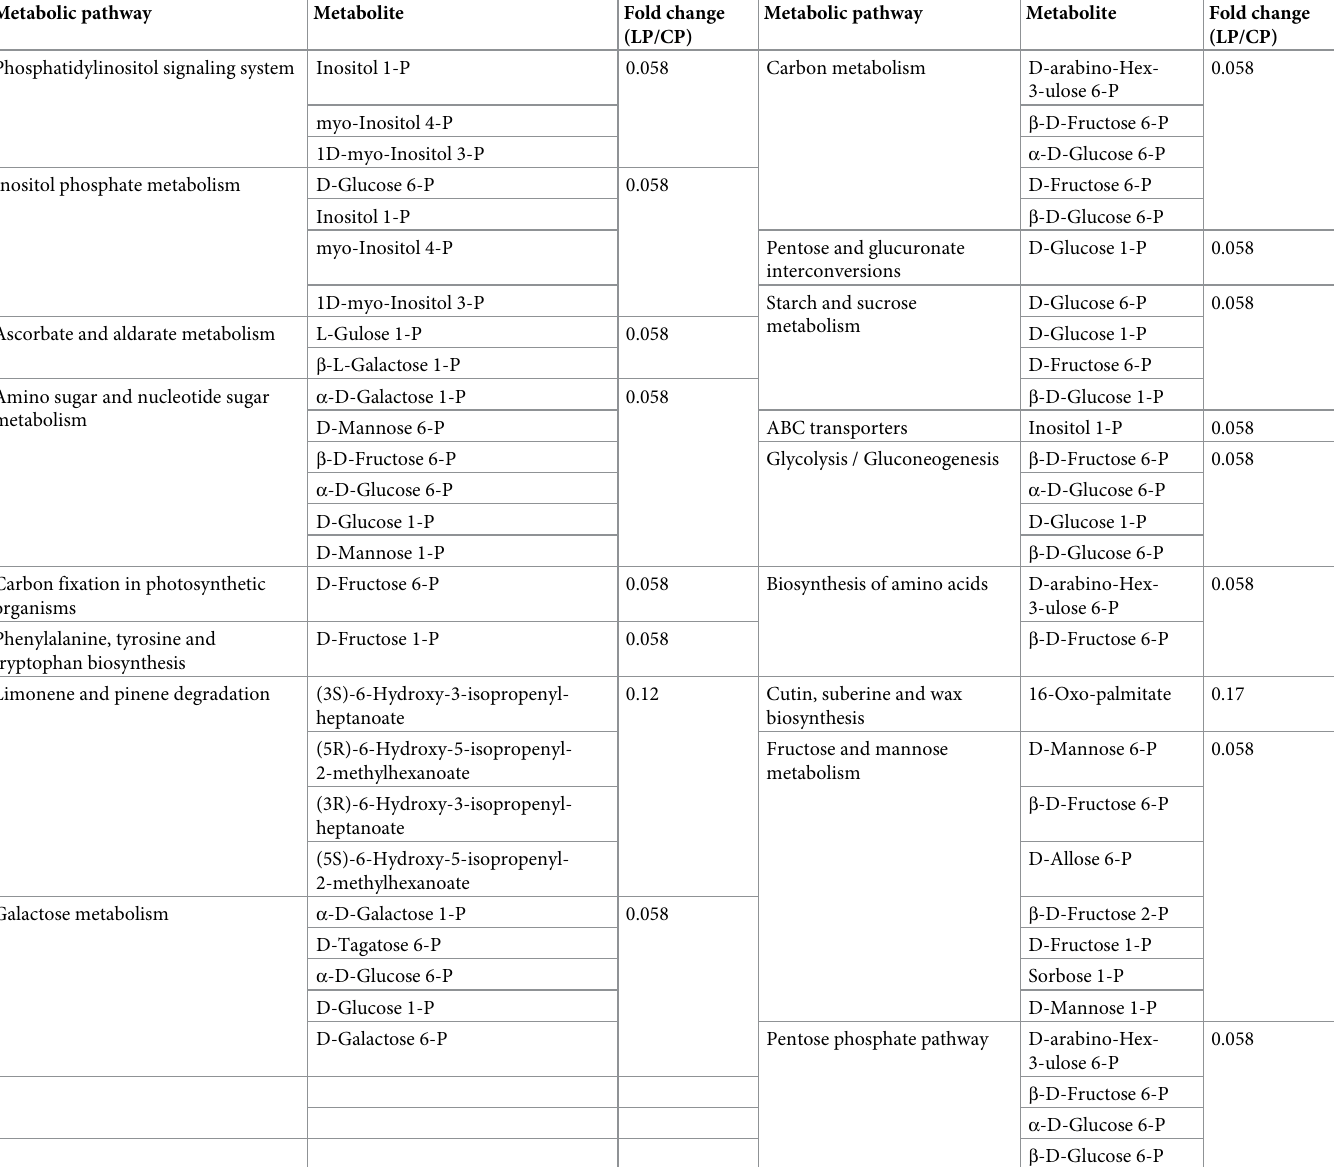
Table 2. Differentially expressed metabolites in roots of Xindong 20 at day 7 under drought stress in LP and CP treatments �